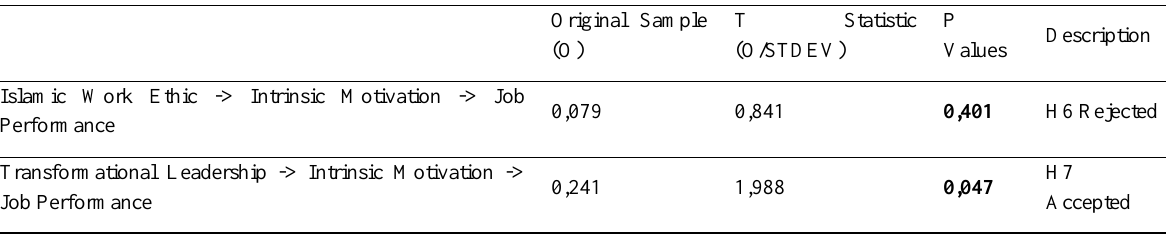
Table 4: Indirect